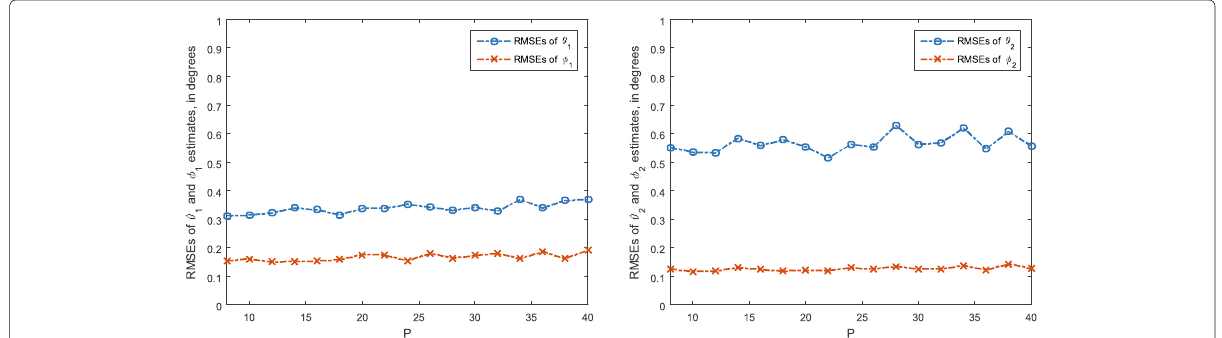
Fig. 3 RMSEs of angle estimates against P . Two uncorrelated signals with θ 1 = 21.13°, φ 1 = 33.69° and θ 2 = 39.82°, φ 2 = 51.34° impinge upon a single-vector sensor. Five hundred independent experiments are